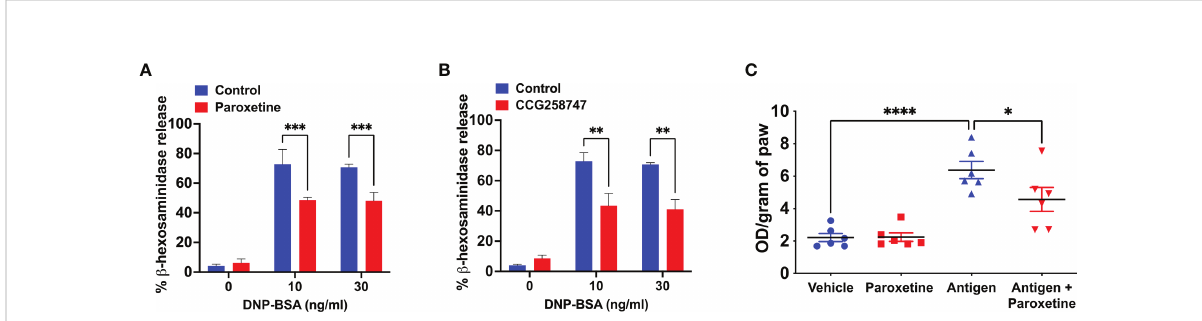
FIGURE 5 Paroxetine inhibits antigen/IgE-mediated MC degranulation in vitro and passive cutaneous anaphylaxis response in vivo in Mrgprb2 − / − mice. IgE- primed Mrgprb2 − / − PMCs were preincubated with (A) paroxetine (30 µM) and (B) CCG258747 (30 µM) and exposed to different concentrations of antigen (DNP-BSA, 0 - 30 ng/mL) and b -hexosaminidase release was measured. Passively sensitized Mrgprb2 − / − mice were intradermally injected with paroxetine (0.1 mg/kg, 30 µL, 30 min, right hind paw) or vehicle (PBS, 30 µL, 30 min, left hind paw) followed by antigen (20 µg, 200 µL in 1% Evans blue dye in PBS, 30 min) or vehicle (200 µL in 1% Evans blue dye in PBS, 30 min) challenge intravenously. (C) Evans blue dye extravasation was determined. Error bars are standard error of mean (SEM) and signi fi cant differences were set at *p ≤ 0.05, **p ≤ 0.01, ***p ≤ 0.001 and ****p ≤